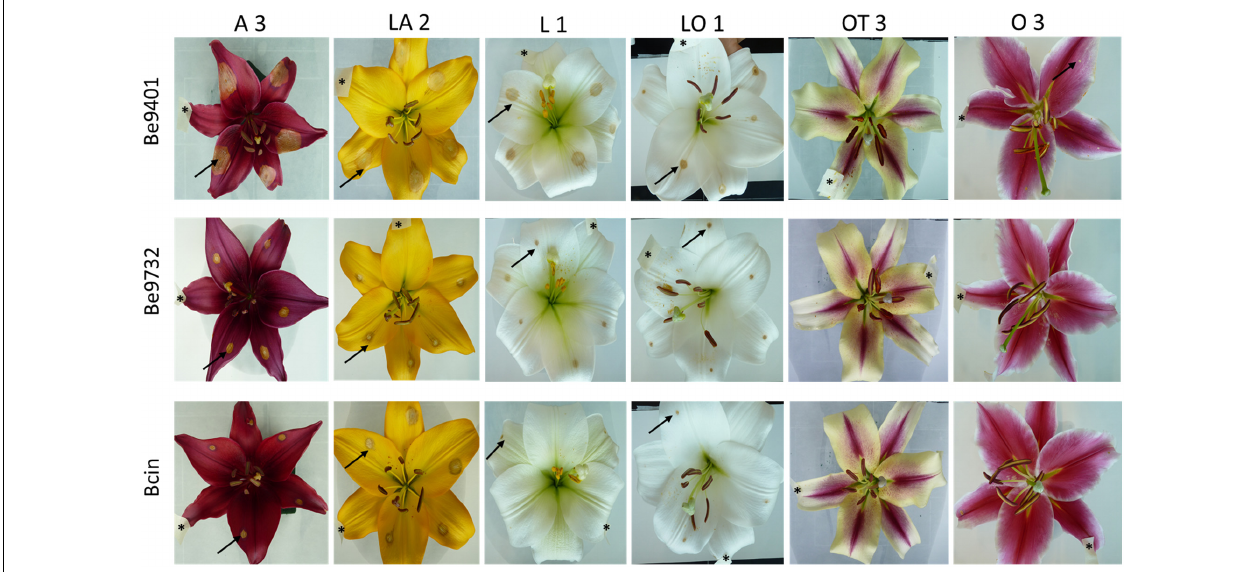
FIGURE 6 | Necrotic lesions at 3 dpi upon inoculation of B. elliptica isolates Be9401, Be9732 and one B. cinerea isolate on flowers of lily genotype A 3, LA 2, L 1, LO 1, OT 3, and O 3. For each cultivar, one representative flower is shown that was inoculated on five different tepals. Black arrows indicate necrotic lesions observed on the tepals. Mock inoculation was labeled with a piece of paper tape on the tepal and is marked with a black asterisk